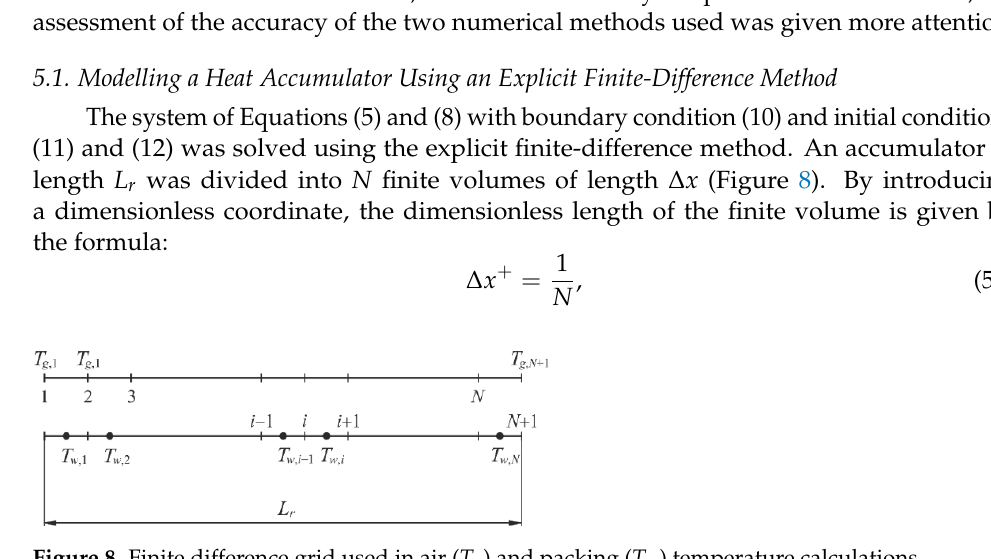
Figure 8. Finite difference grid used in air ( T g ) and packing ( T w ) temperature calculations.